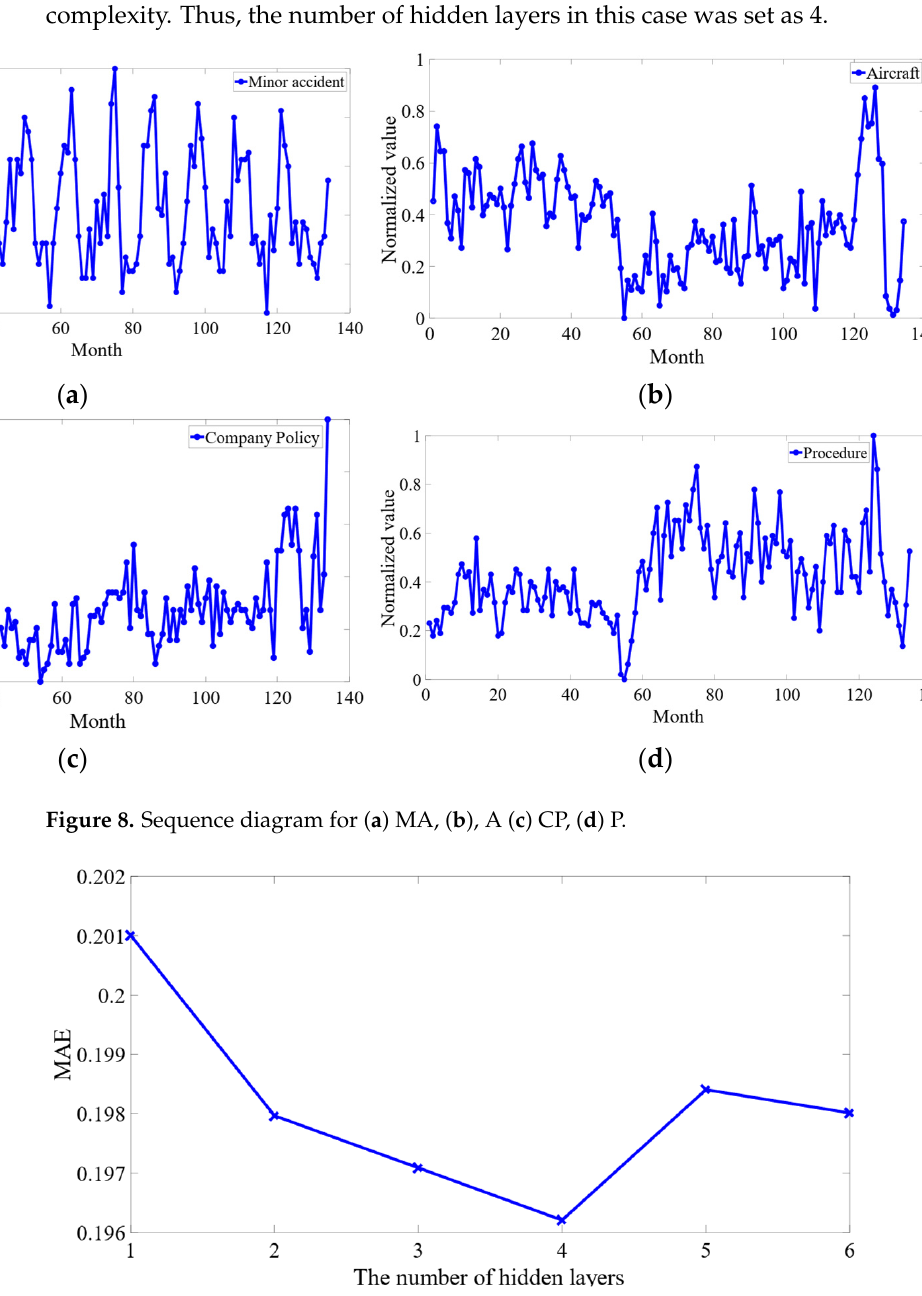
( b ) Figure 10. Changes of training accuracy under different number of nodes in the (a) 1st and 2nd hidden layer, (b) 3rd and 4th hidden layer. 4. Model Comparison 4.1. Effect of Predictors on the Experimental Results The model proposed in this paper based on the MSSLSTM will be compared with prediction models such as ' LSTM , LSTM, MSSRNN, TCN, DT, SVR, and ARMA. Those compared models were all used to predict the value of aviation safety level in the same experimental environment. The comparison experiment results of each model are shown in Figure 11.